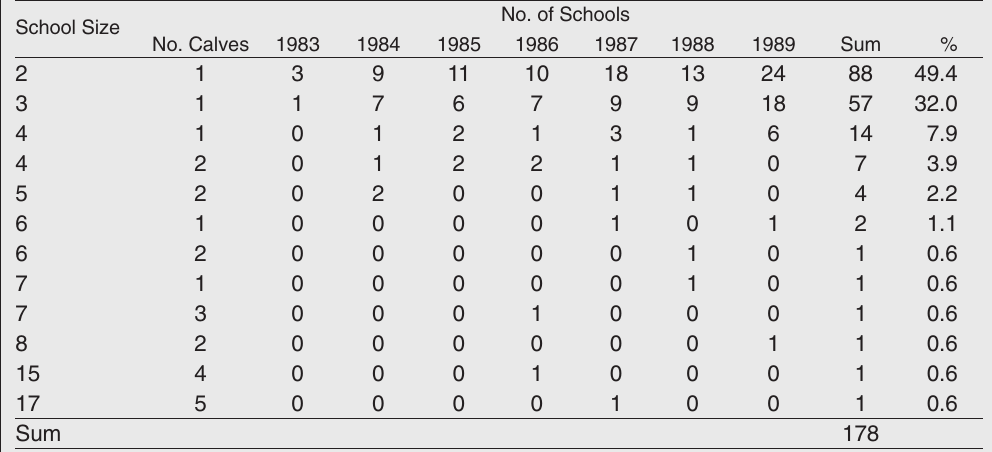
Table 3. Composition of schools including calves by years (observations combined).